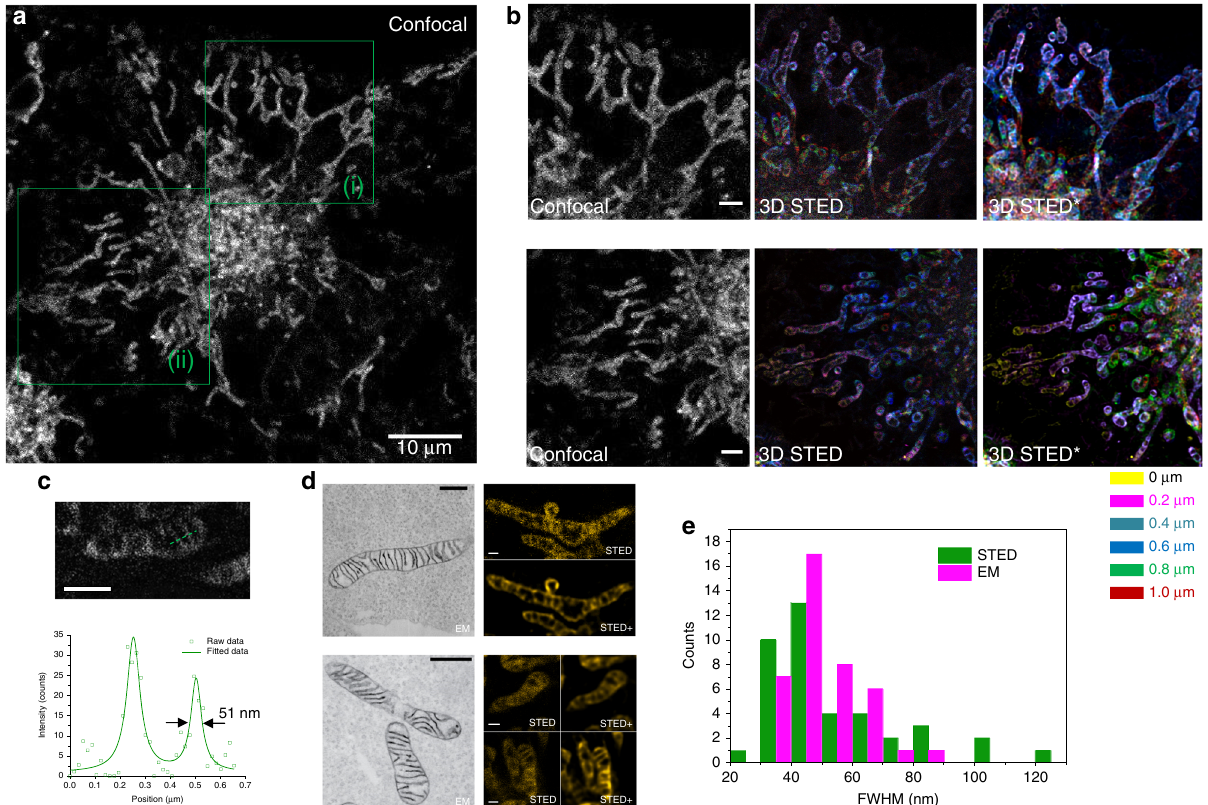
Fig. 2 3D STED z-stack with superresolution imaging of the mitochondria in HeLa cells with MitoESq-635. a 2D confocal image of mitochondria labelled with an enhanced squaraine probe in living HeLa cells. b Colour-coded STED imaging of the 3D stack (raw data) of the corresponding green boxed area (i, ii) in a ; the, upper three images are in (i), and the lower three images are in (ii). The image labelled STED asterisk is the corresponding deconvolved image of the STED image; different colours indicate different deaths. c A zoom-in view and resolution plot of mitochondrial cristae. d In the STED images and the corresponding deconvoluted images (labelled STED plus), the cristae structures in living cells can de fi nitely be resolved and can be compared to the previously reported engineered peroxidase (APEX 2)-labelled electron microscopy (EM) images that were reprinted by permission from Springer Nature Customer Service Centre GmbH: Nature, Nature Methods (Directed evolution of APEX2 for electron microscopy and proximity labelling, Stephanie S Lam et al.), Copyright (2014), (https://www.nature.com/articles/nmeth.3179) 25 ; scale bars in EM and STED images are 500 nm and 1 μ m, respectively. e Cristae width distribution histogram based on STED and EM images. The raw data for the STED images (1024 × 1024 pixels) in different layers of b are shown in Supplementary Movies 2 and 3, in which the z-step size is 200 nm, the 635 nm laser used for excitation, and the 775 nm laser used for depletion at the back focal plane of the objective were 5.2 μ W and 36 mW, respectively; the pixel dwell time was 4 μ s. Scale bars in a – c are 10, 2 and 1 μ m, respectively. The scale bars of the EM and STED fl uorescence images in d are 500 nm and 1 μ